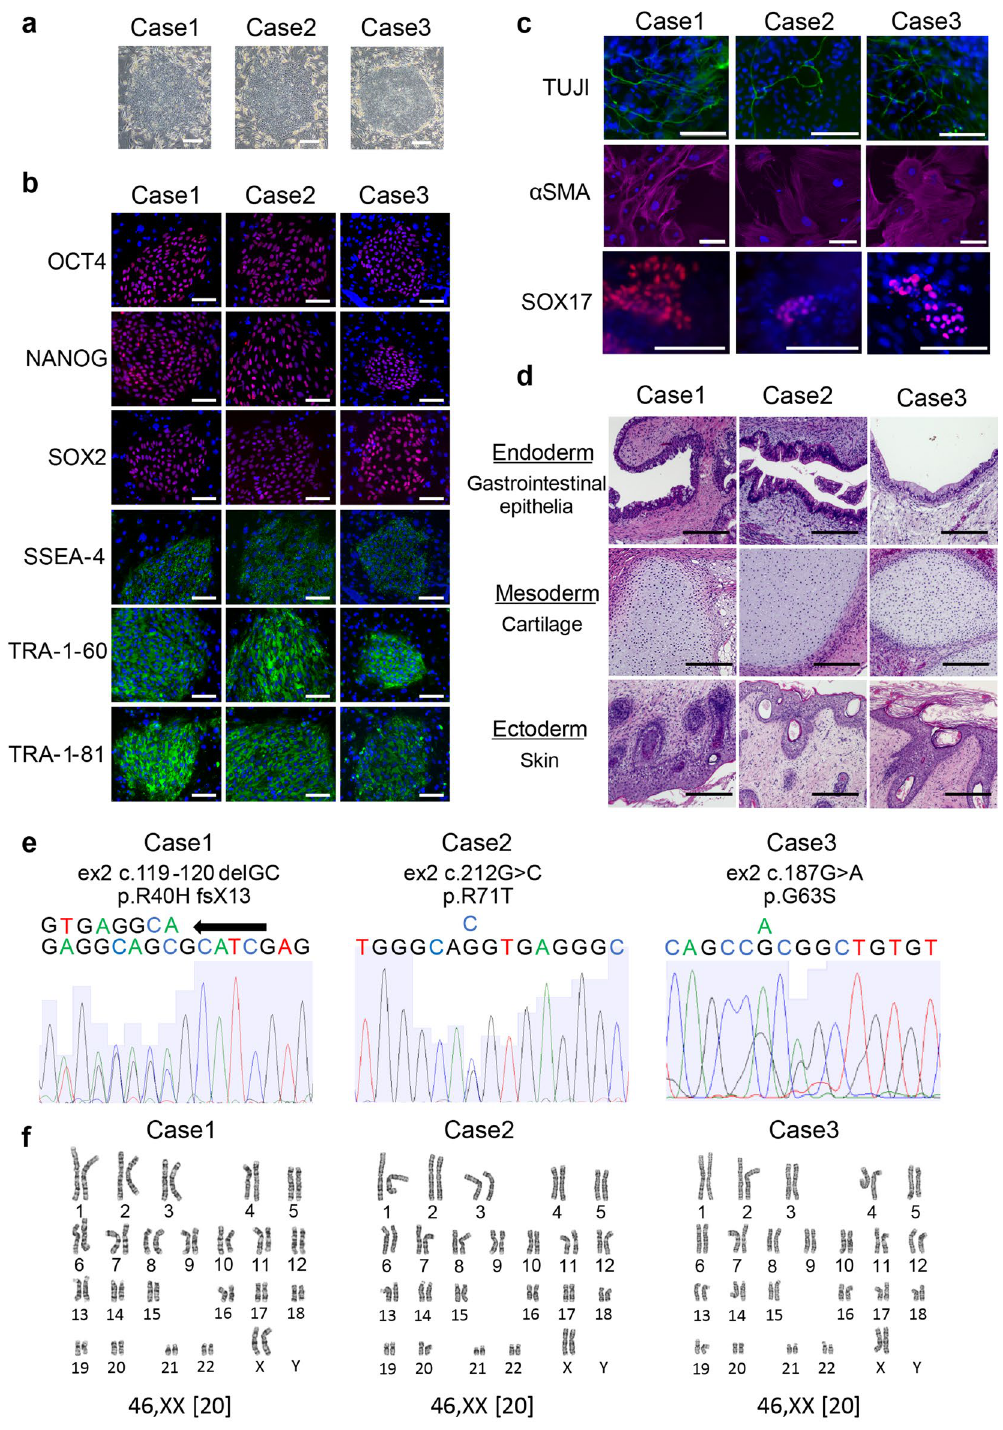
Figure 1. Establishment of induced pluripotent stem cells (iPSCs) from three patients with renal coloboma syndrome (RCS). ( a ) Representative morphology of iPSCs from patients with RCSs. The scale bars represent 100 μm. ( b ) Immunocytochemical analysis of pluripotent markers, OCT4, NANOG, SOX2, SSEA4, TRA-1–60, and TRA-1–81. The scale bars represent 100 μm. ( c ) After 16 days of differentiation of iPSCs with EB formation, the cells were stained with anti-TUJI (ectoderm), αSMA (mesoderm), and SOX17 (endoderm) antibodies. Scale bars represent 100 μm. ( d ) RCS-iPSCs transplanted into immunocompromised nonobese diabetic/severe combined immunodeficient (NOD-SCID) mice developed teratomas containing tissues from three germ layers. These images show the characteristic structure of three germ layers in the teratoma. The scale bars represent 200 μm. ( e ) Representative Sanger sequencing analysis of the mutations in the PAX2 gene using RCS-iPSCs. Identical mutations to those observed in patients were confirmed in all iPSC clones. ( f ) Normal karyotype by G-banding of